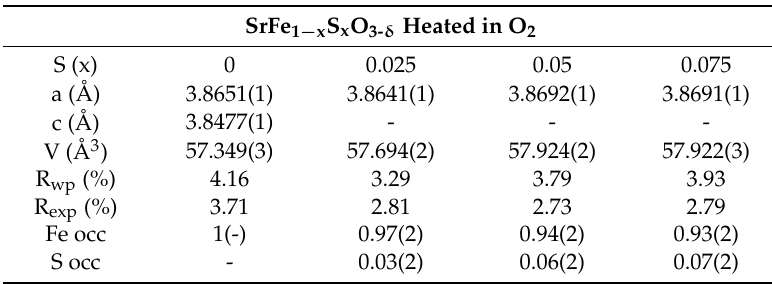
Table 3. Lattice parameters and Fe/S site occupancies for SrFe 1 − x S x O 3- δ , obtained from Rietveld